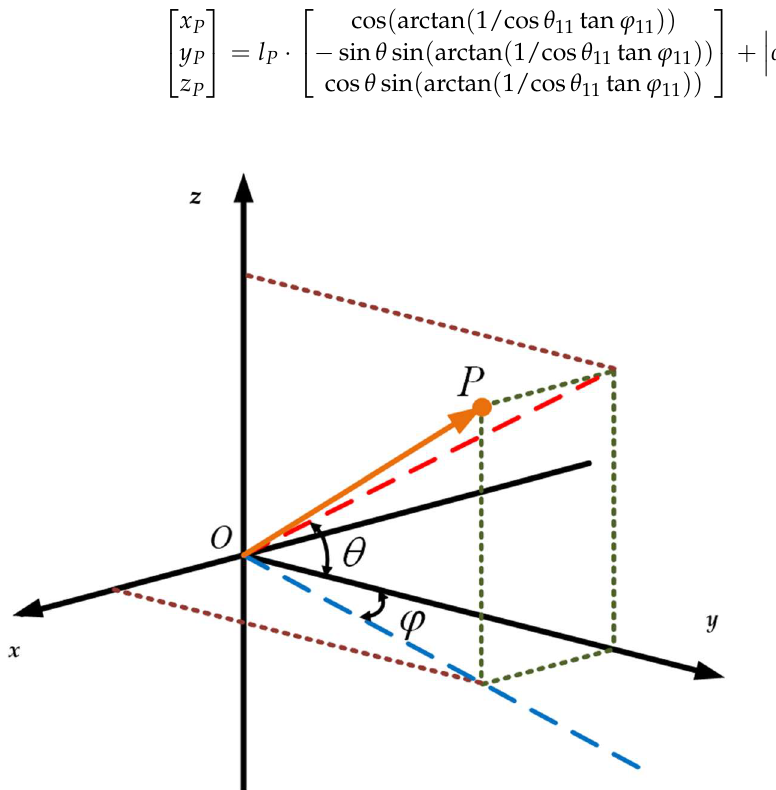
Figure 4. Schematic diagram of solving point P coordinates.